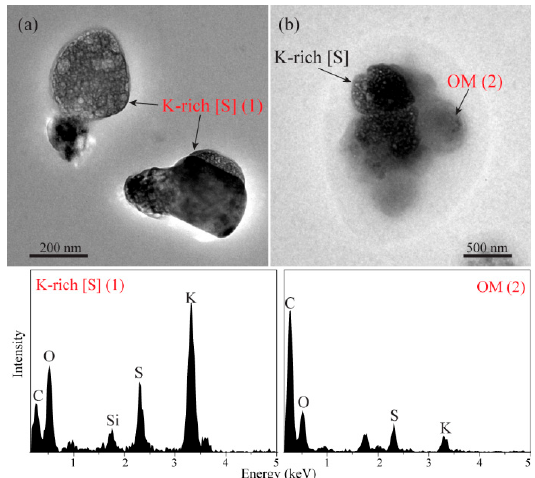
Figure 3. TEM images of K-rich particles. ( a ) K-rich particles; ( b ) K-rich particle internally mixed with OM particle. EDS spectra shows the elemental composition of individual particles in red font in TEM images.